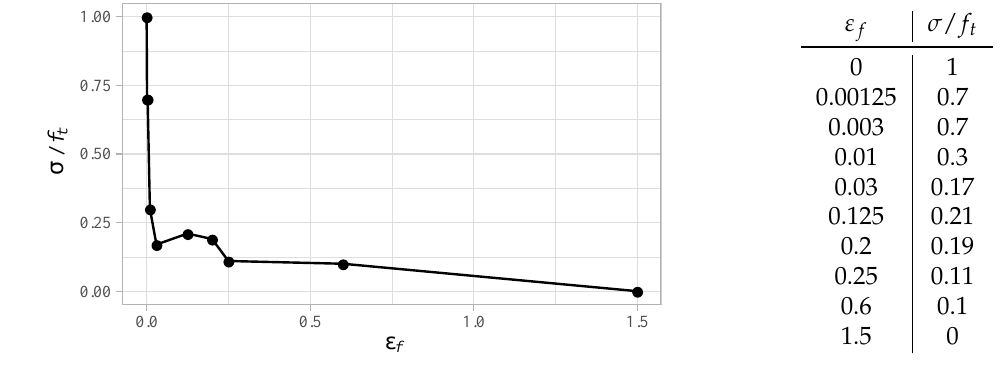
Figure 5. Tension function of SFRC and its numerical values used in the